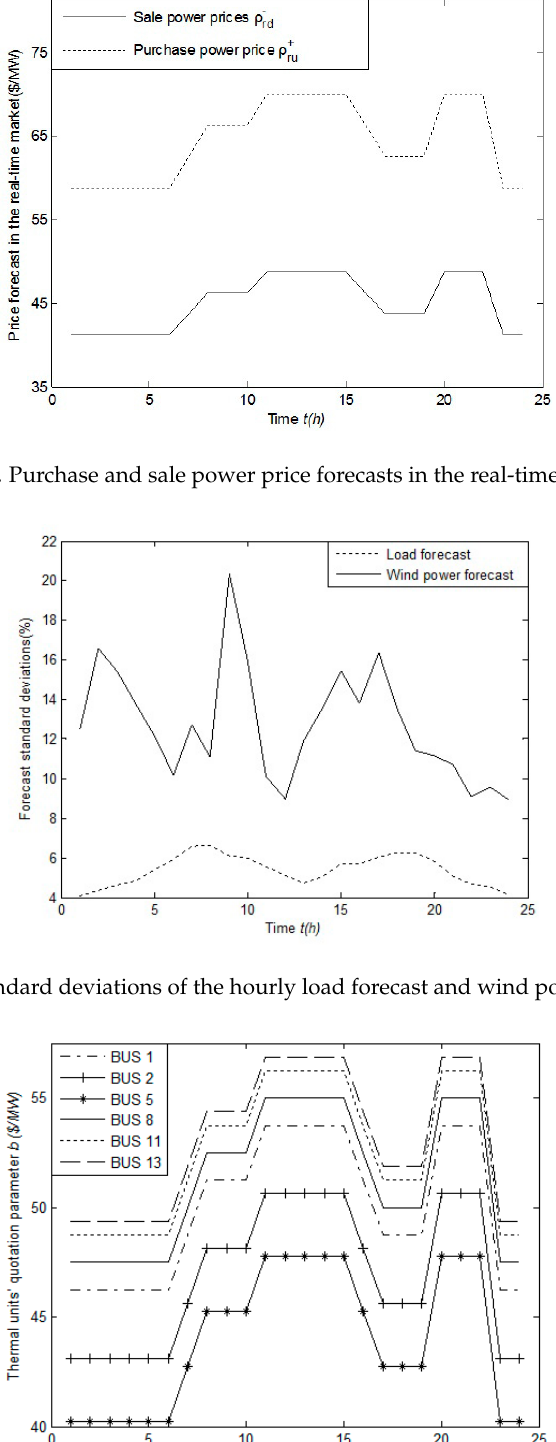
Figure 3. Hourly load and wind power forecasts.